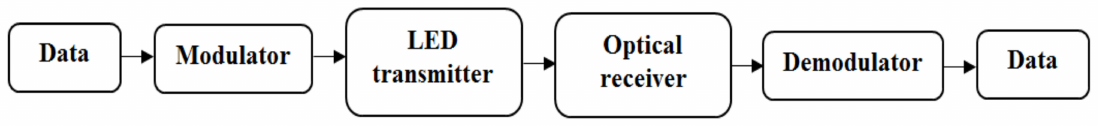
Figure 1. Overview of the VLC